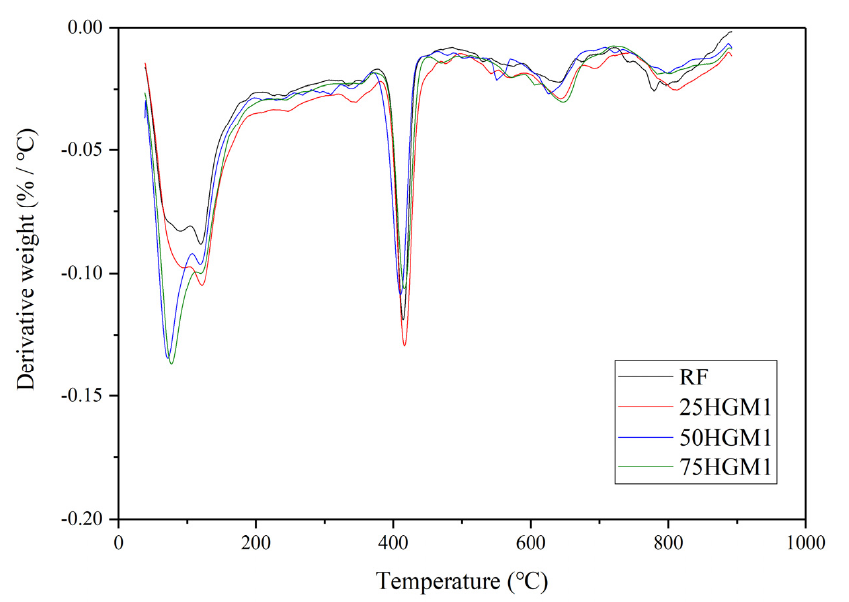
Figure 8. TGA results of HGM1 specimens.